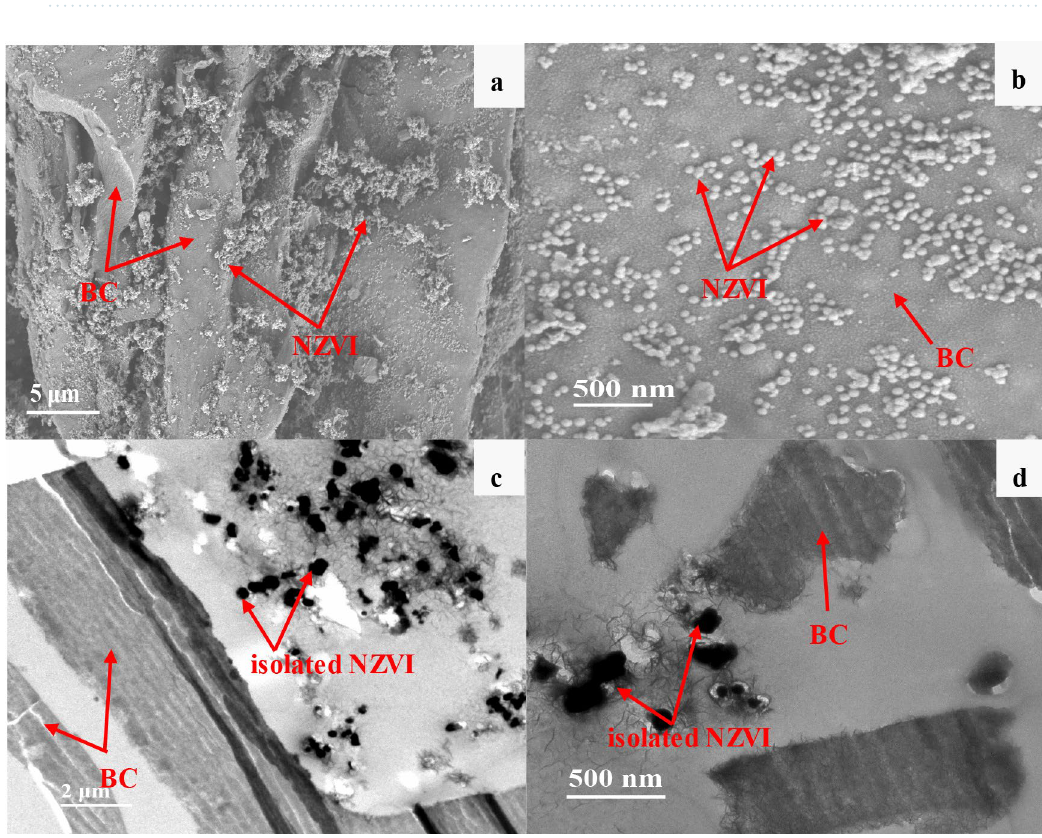
Figure 5. SEM ( a , b ) and C-TEM images ( c , d ) of NZVI +